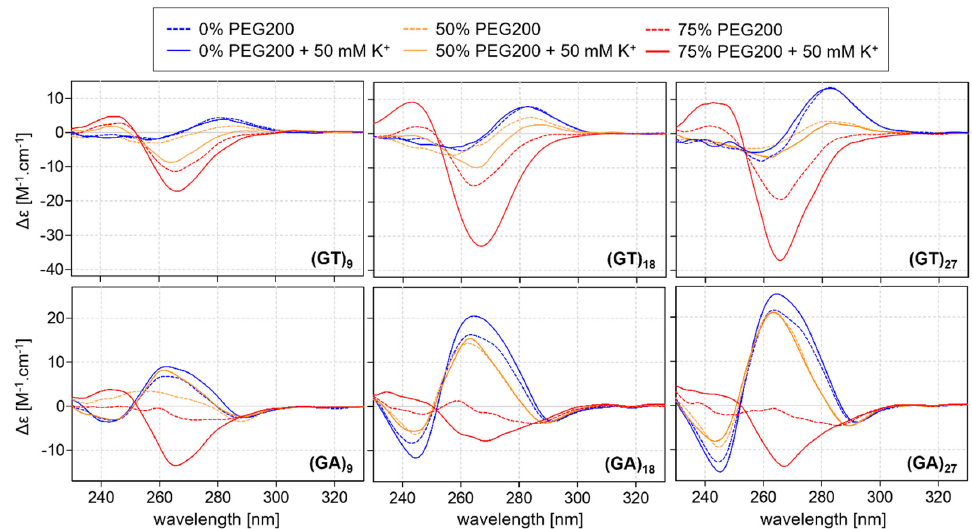
Figure 2. CD spectra of (GT) n and (GA) n in mBR in the presence and absence of 50 mM KCl and pH 7.4 (solid and dashed blue lines, respectively) and with the addition of 50% and 75% PEG200 (red and orange lines, respectively).